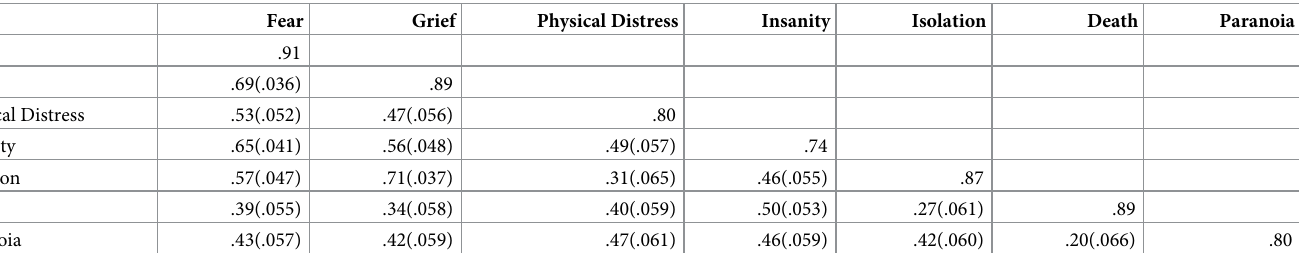
Table 3. Factor correlations and factor reliabilities for the CEQ.